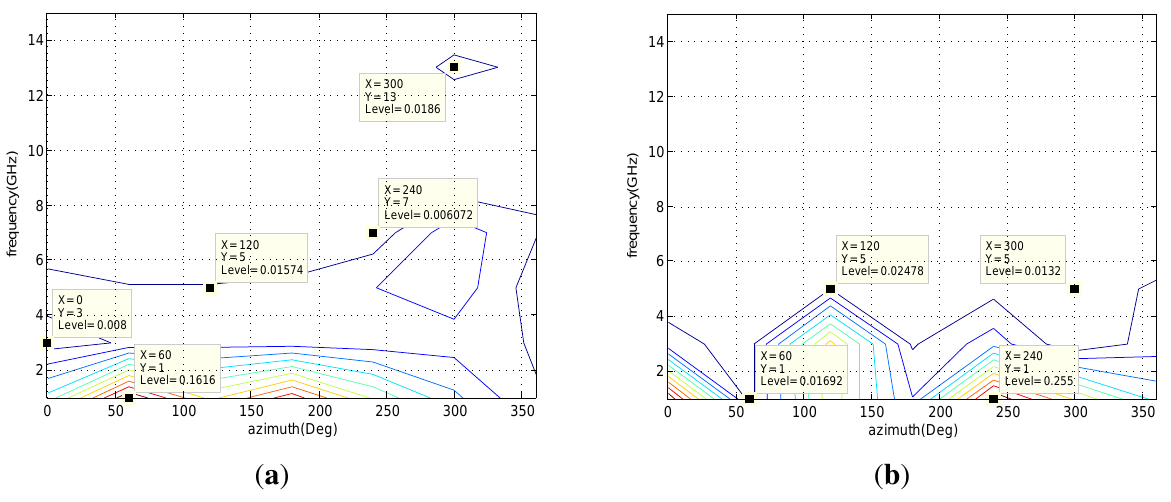
Figure 15. Comparison of RMSE with different